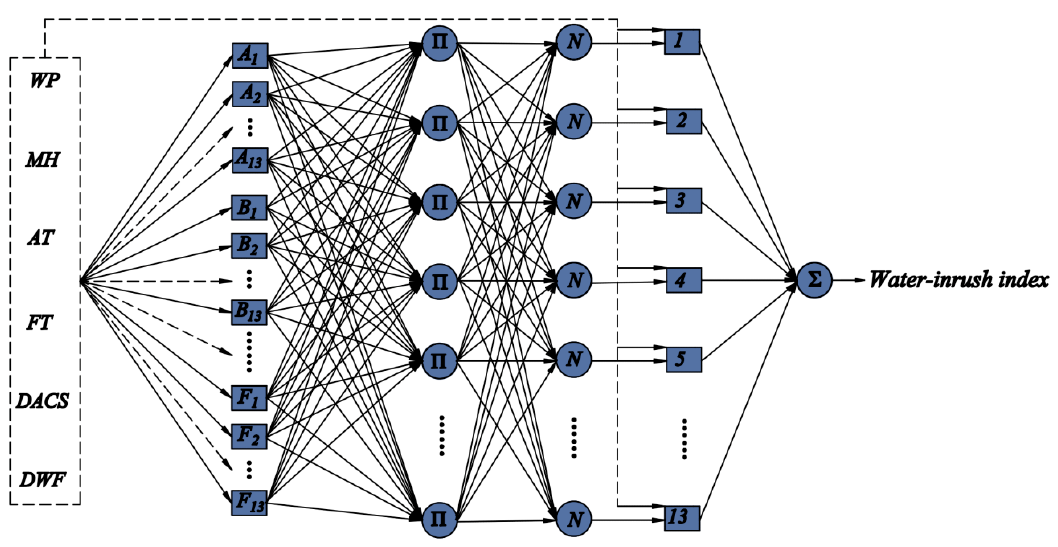
Figure 5. ANFIS structure used for the assessment of the water inrush index.